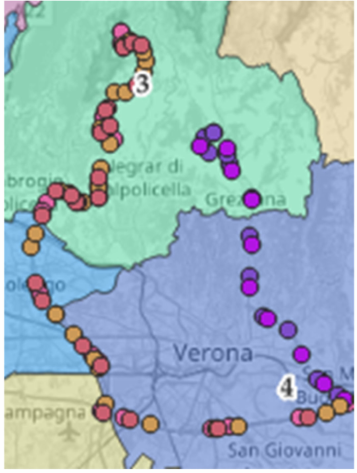
Figure 5. Veneto data: example of routes.